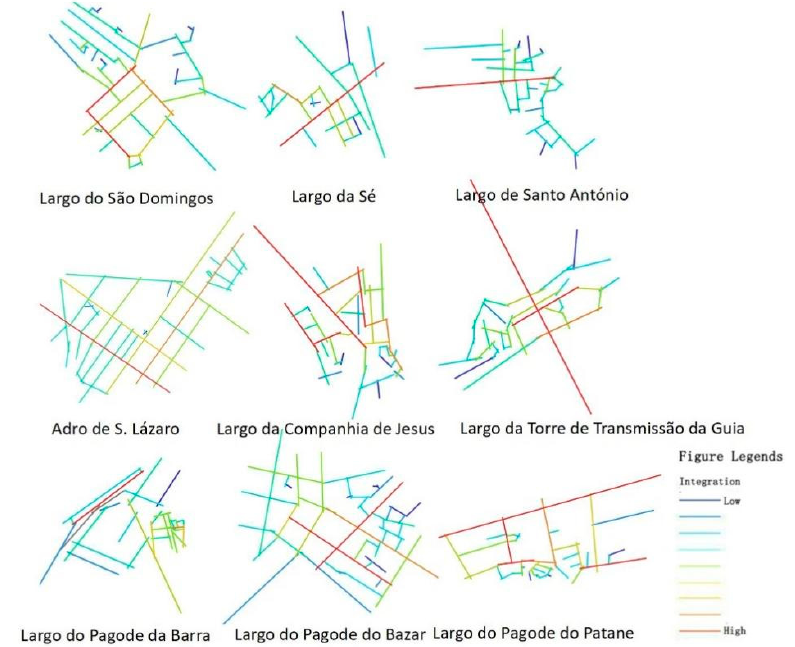
Figure 15. Religion-related Largos.